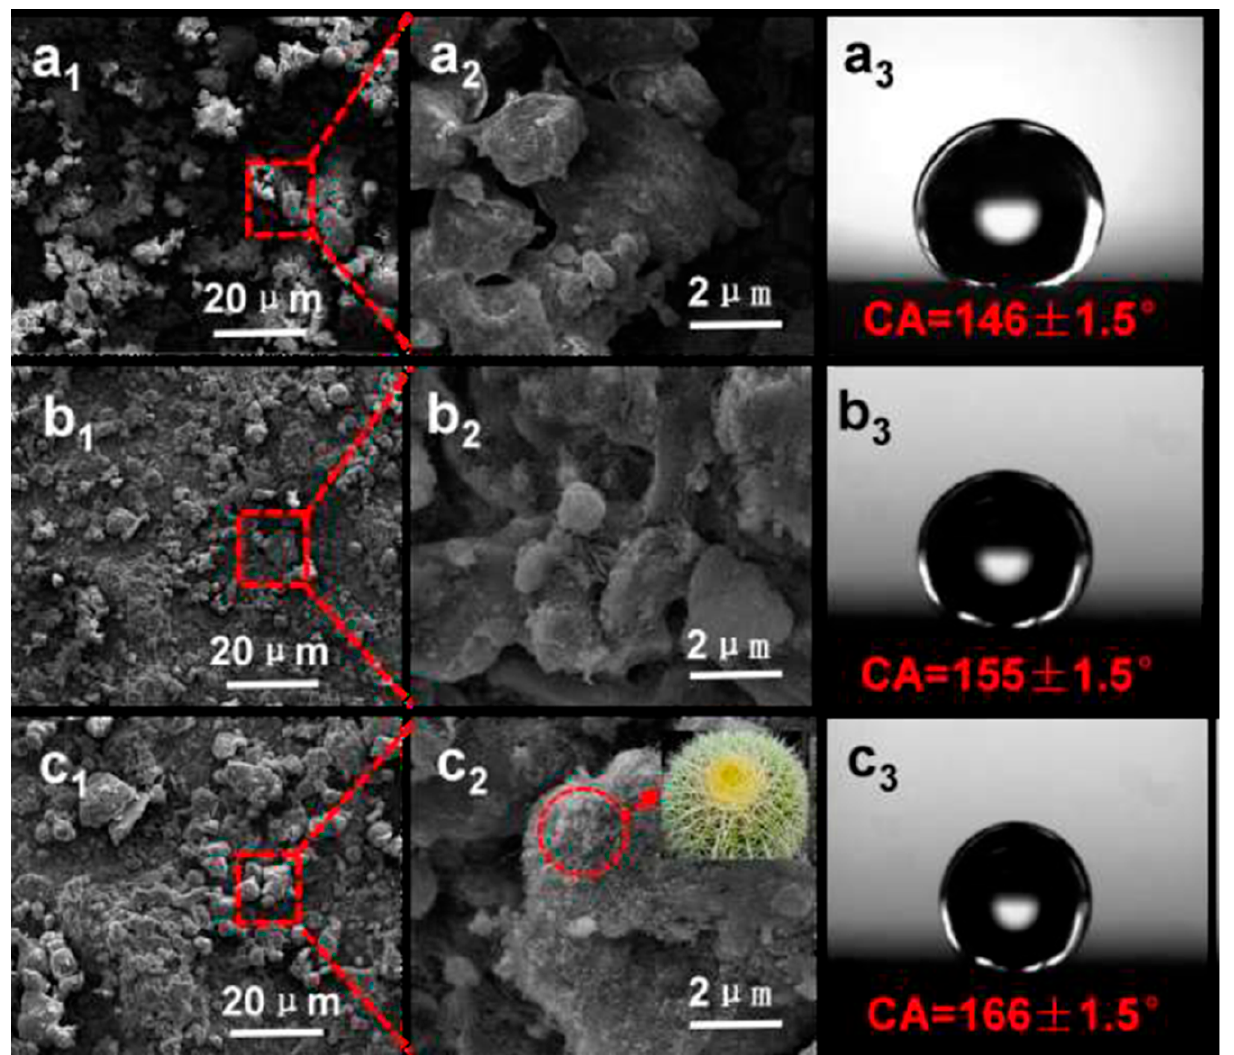
Figure 14. SEM imaging of PCFn surfaces showing GC-like structured coatings reminiscent of biomimetic features with variable content of ( a1 – a3 ) 0 wt%, ( b1 – b3 ) 1 wt%, and ( c1 – c3 ) 5 wt% CNTs. Insert ( c2 ): An optical image of a golden spherical cactus. Reprinted with permission from [188]. 2018, Chem. Eng. Table 5. Biomimicry in functionalized carbon-based coating technology.